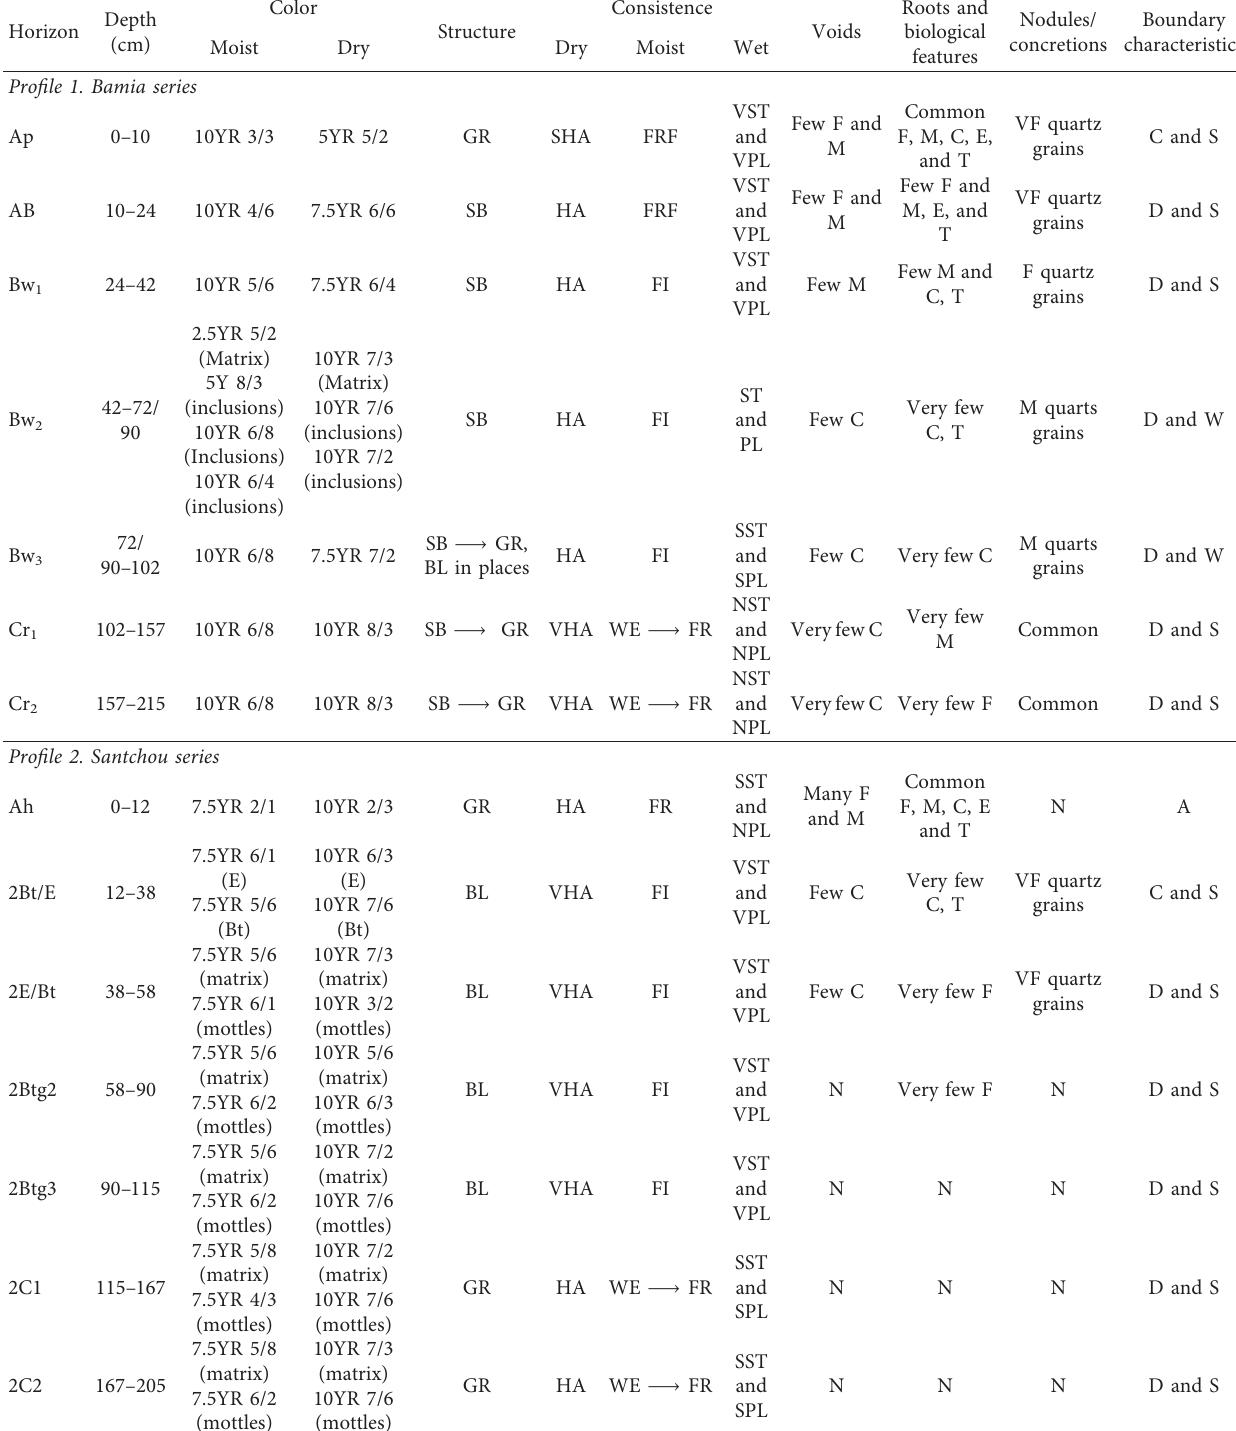
Table 3: Morphological characteristics of the